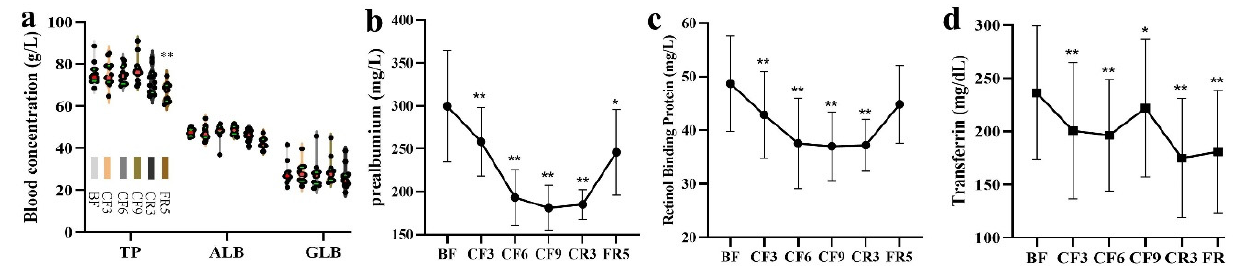
Figure 3. The changes of nutrition protein indicators during 10-day CF and refeeding period. ( a ) the blood concentration of nutritional protein indicators; ( b ) prealbumin ( c ) retinol binding protein ( d ) transferrin. * p < 0.05, ** p < 0.01, vs. BF; n = 13. BF: before fasting, CF: complete fasting, CR: calorie restriction, FR: full recovery; the number depicts days. TP: total protein, ALB: albumin, GLB: globin.